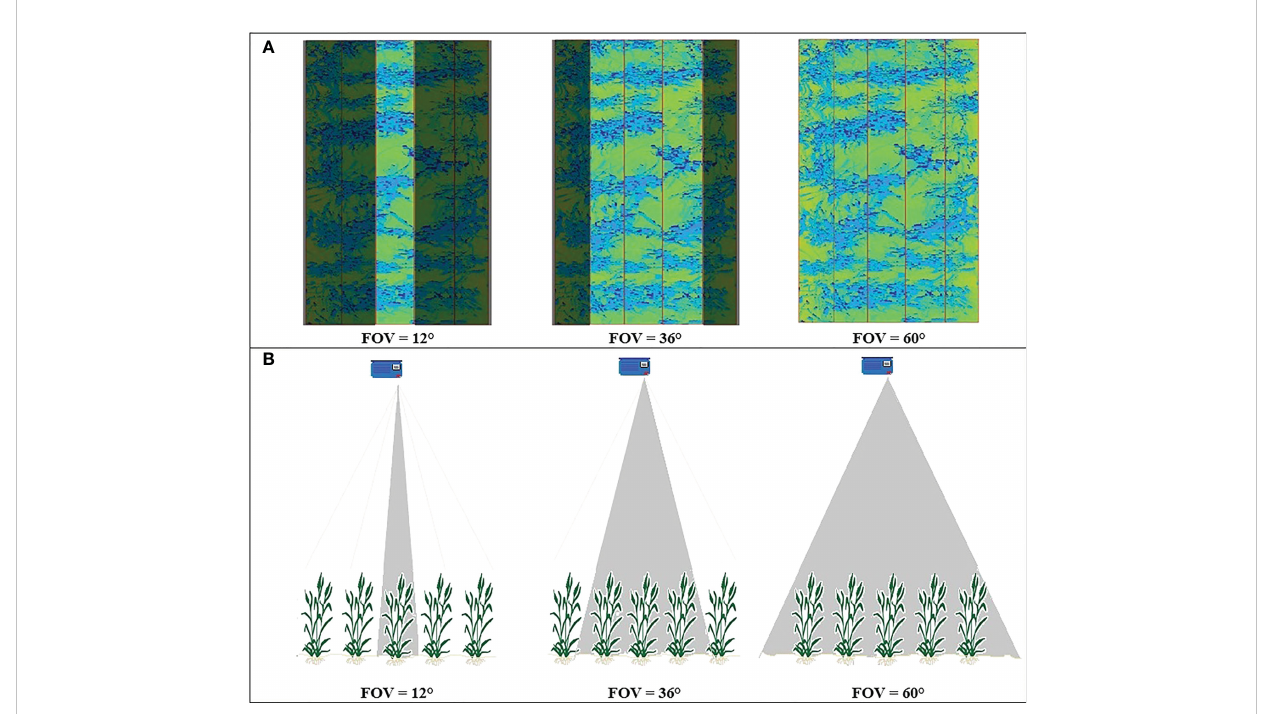
FIGURE 3 (A) the LiDAR images obtained from a typical plot on 15/08/2019, highlighting the scanned region covered by different angular FOV. (B) a representation of the FOV geometry viewed perpendicularly from the scanning